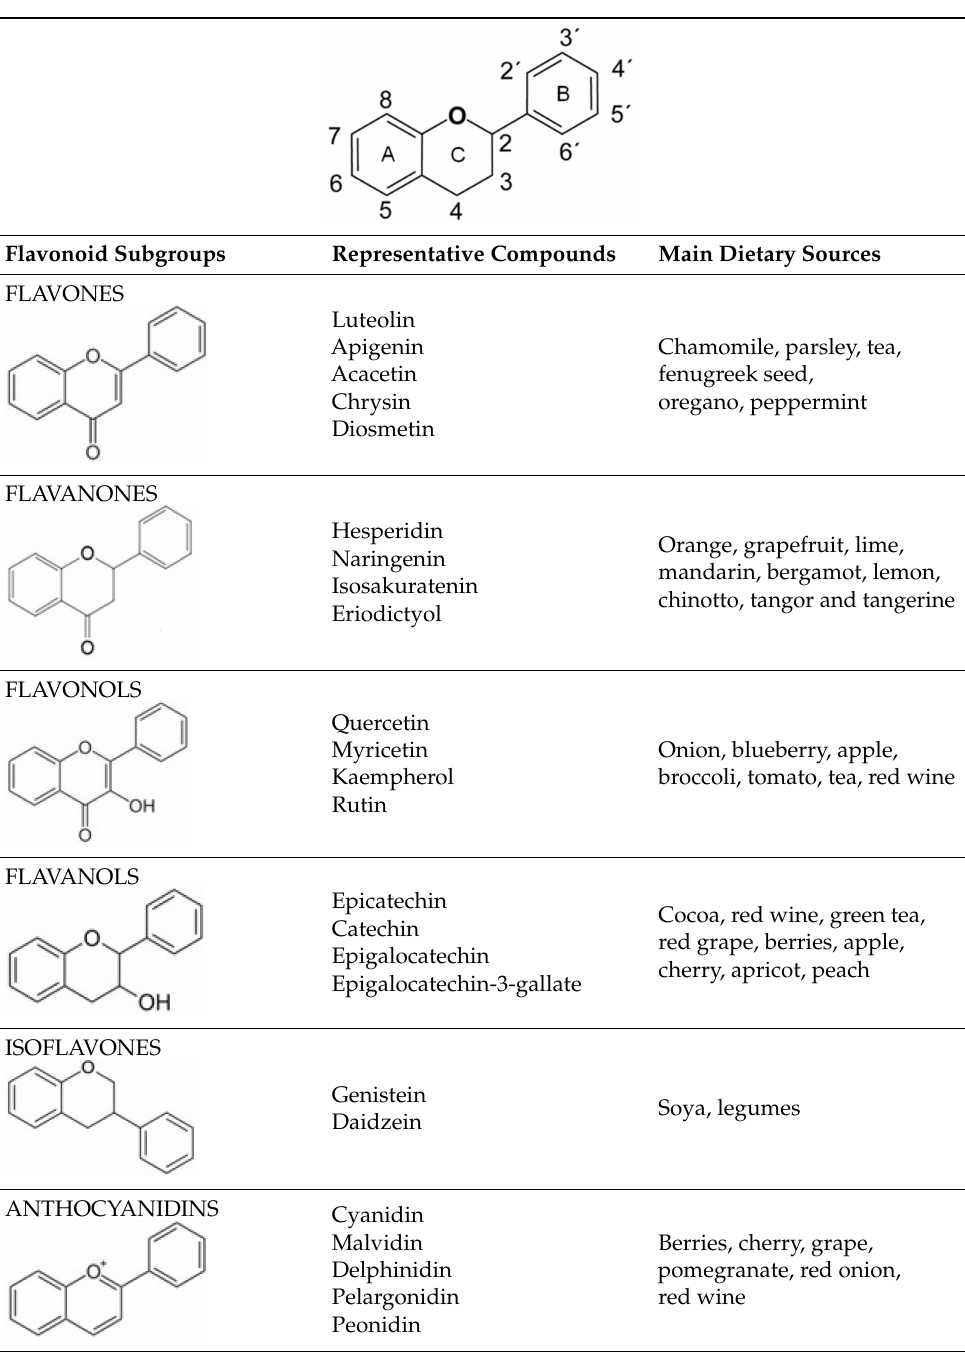
Table 1. Basic chemical structure of flavonoids and flavonoids subgroups with representative compounds and main dietary